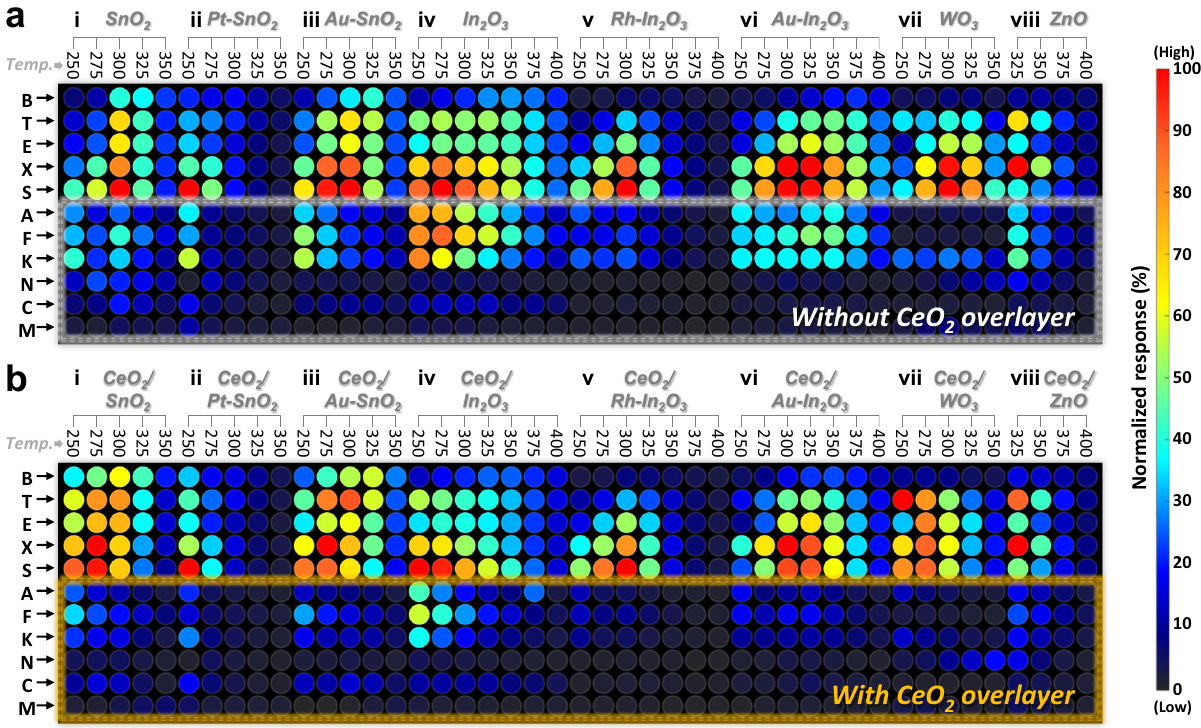
Fig.7|Gas-sensingpatternsfordiversesensors.a , b Normalizedsignalintensities of diverse single-layersensors( a ; (i) SnO 2 , (ii)Pt – SnO 2 , (iii)Au – SnO 2 , (iv) In 2 O 3 , (v) Rh – In 2 O 3 , (vi) Au – In 2 O 3 , (vii)WO 3 , and (viii) ZnO)andCeO 2 -coated bilayersensors ( b ; (i) 0.4CeO 2 /SnO 2 , (ii) 0.4CeO 2 /Pt – SnO 2 , (iii) 0.4CeO 2 /Au – SnO 2 , (iv) 0.4CeO 2 /